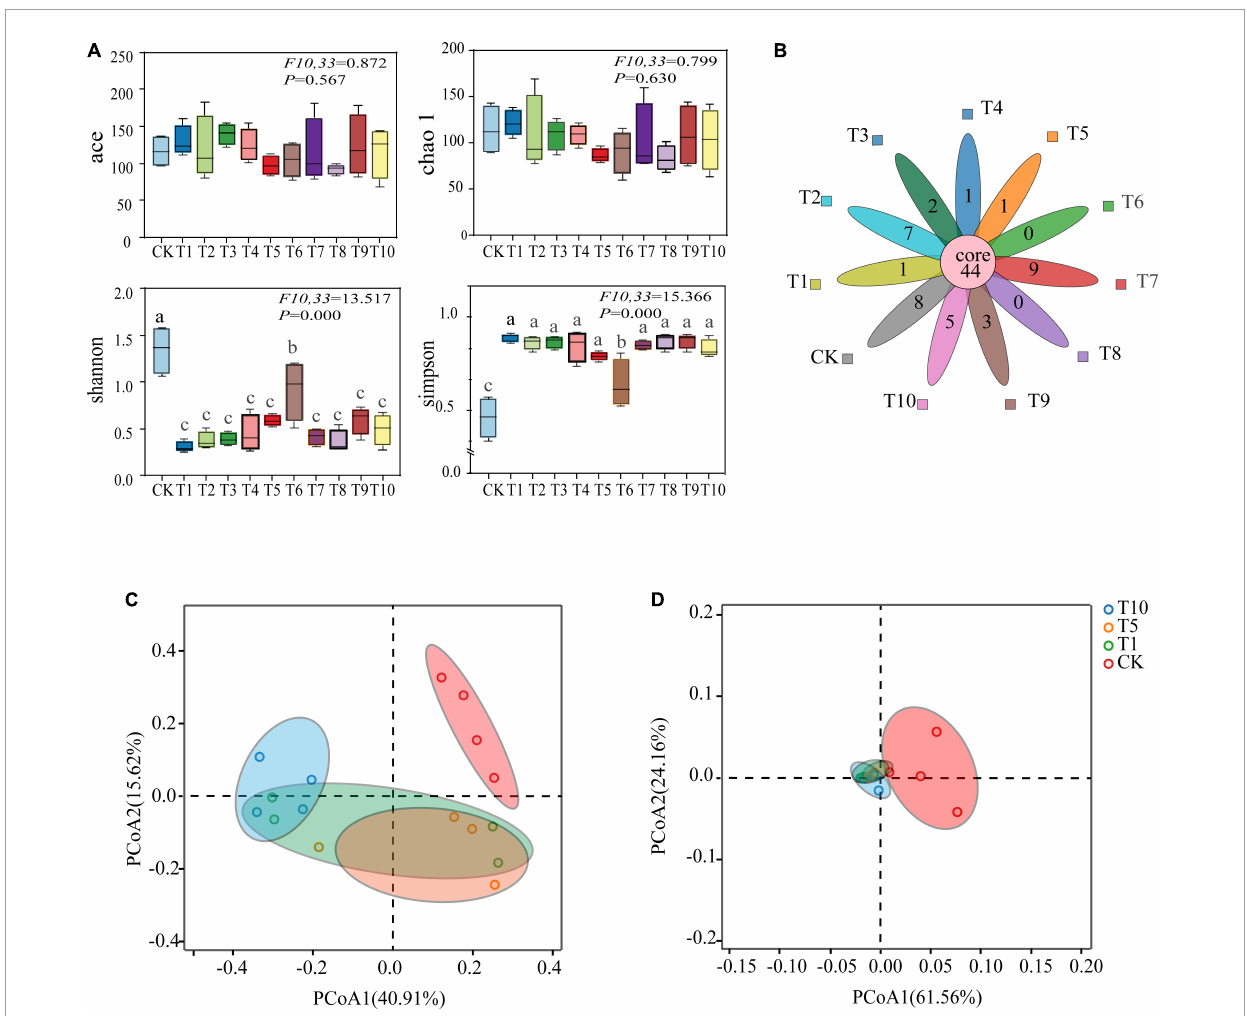
FIGURE1 Sequencing analysis of 16S rDNA gene amplicons of cotton-specialized aphids with diversity indices. (A) Boxplot of α -diversity measured by the four indexs. (B) Core-Pan OTU presentation of the common and unique OTUs of all samples in the petal diagram. (C) Unweighted UniFrac metrics were used to determine pairwise distances among all of the samples. (D) Wighted UniFrac metrics were used to determine pairwise distances among all of the